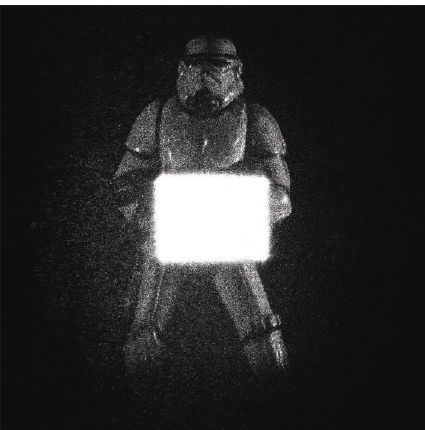
Figure 2: Reconstructed DH of a Starwars schart. Note the presence of the both the DC terms and the conjugate image term.